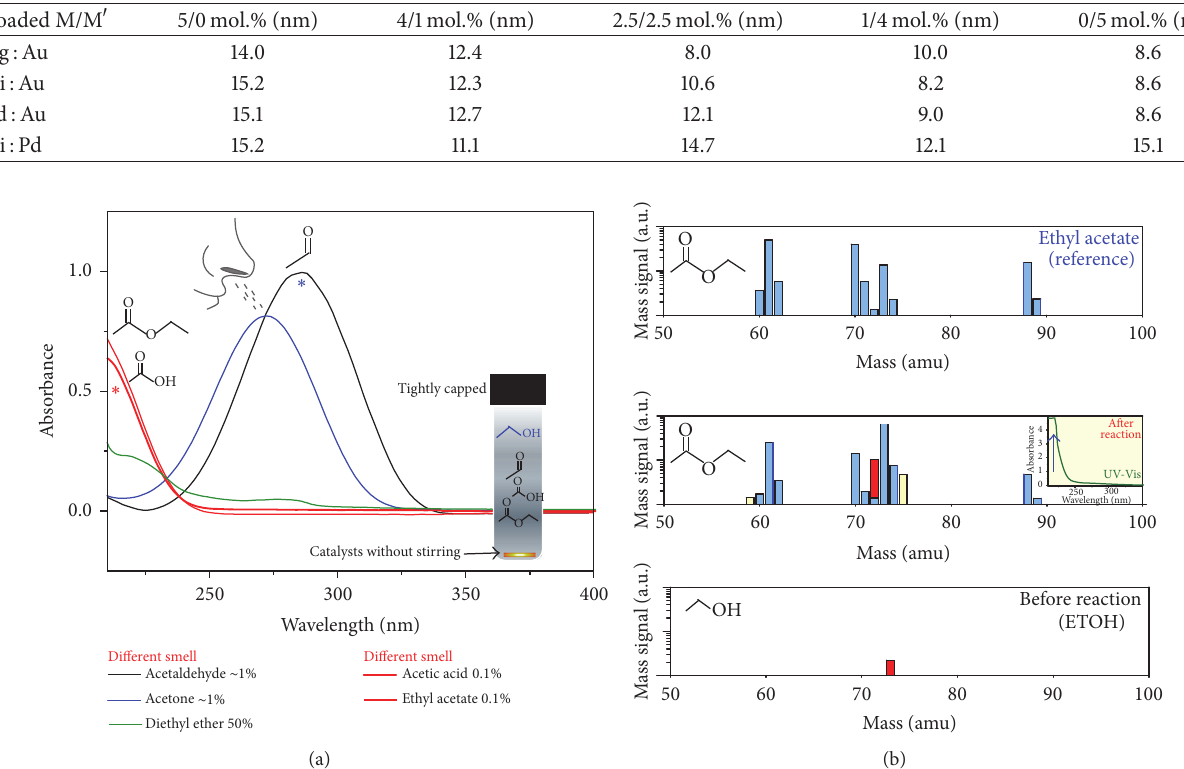
Table 1: Particles sizes of the metal-loaded CeO 2 estimated using Scherrer’s equation.